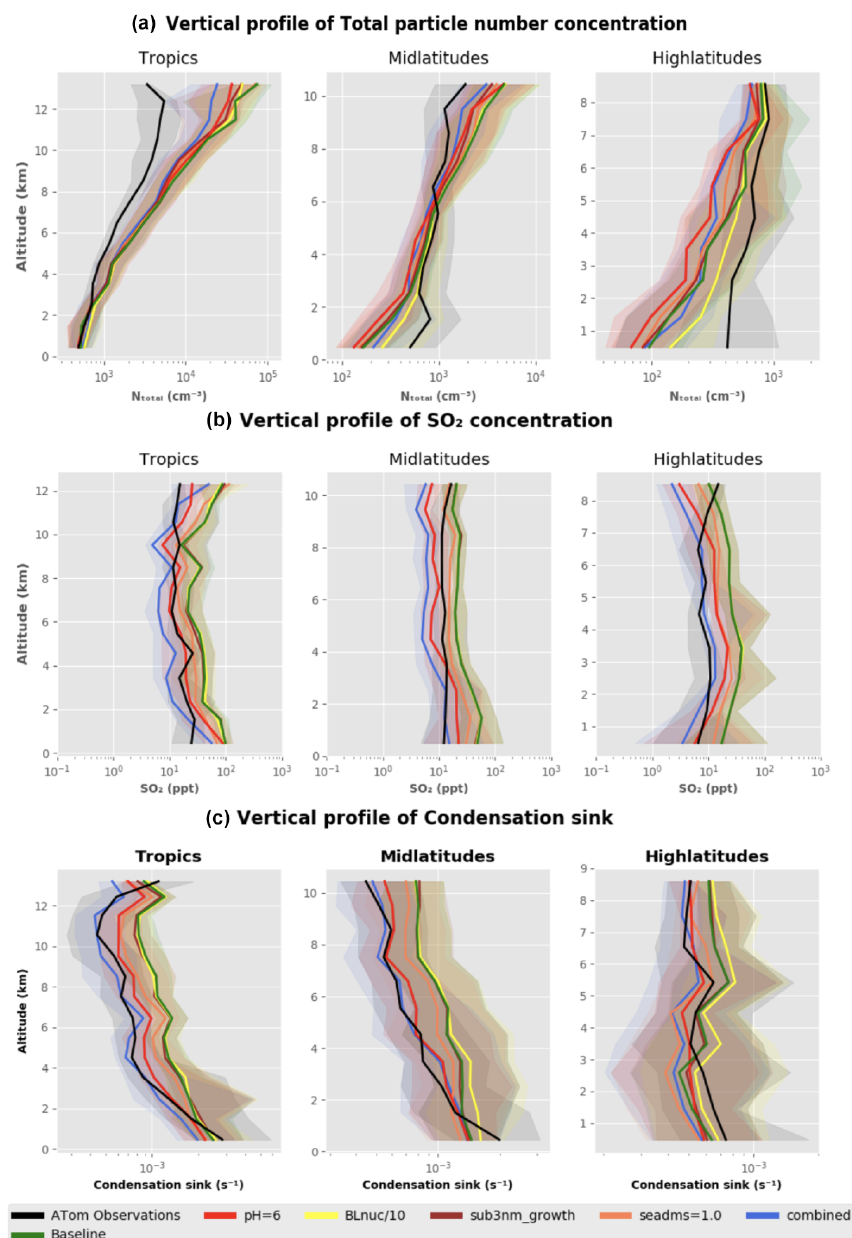
Figure 9. The vertical profile of (a) N Total , (b) SO 2 and (c) condensation sink for different model experiments that were found to have the most influence on model performance. The vertical profiles of observation data, the baseline simulation and perturbation simulations of cloud pH, boundary layer nucleation, sub-3nm growth, scaled-down DMS emissions, and the combined simulation are shown and categorised into three regions of the Earth: the tropics (25 ◦ N–25 ◦ S), mid latitudes (25–60 ◦ N and 25–60 ◦ S), and high latitudes (60–90 ◦ N and 60–90 ◦